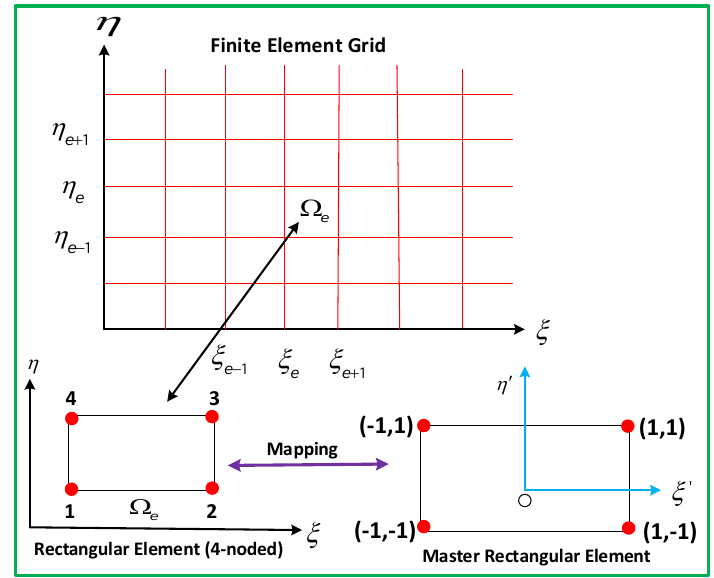
Figure 2. Finite element grid and finite element mesh of rectangular element.